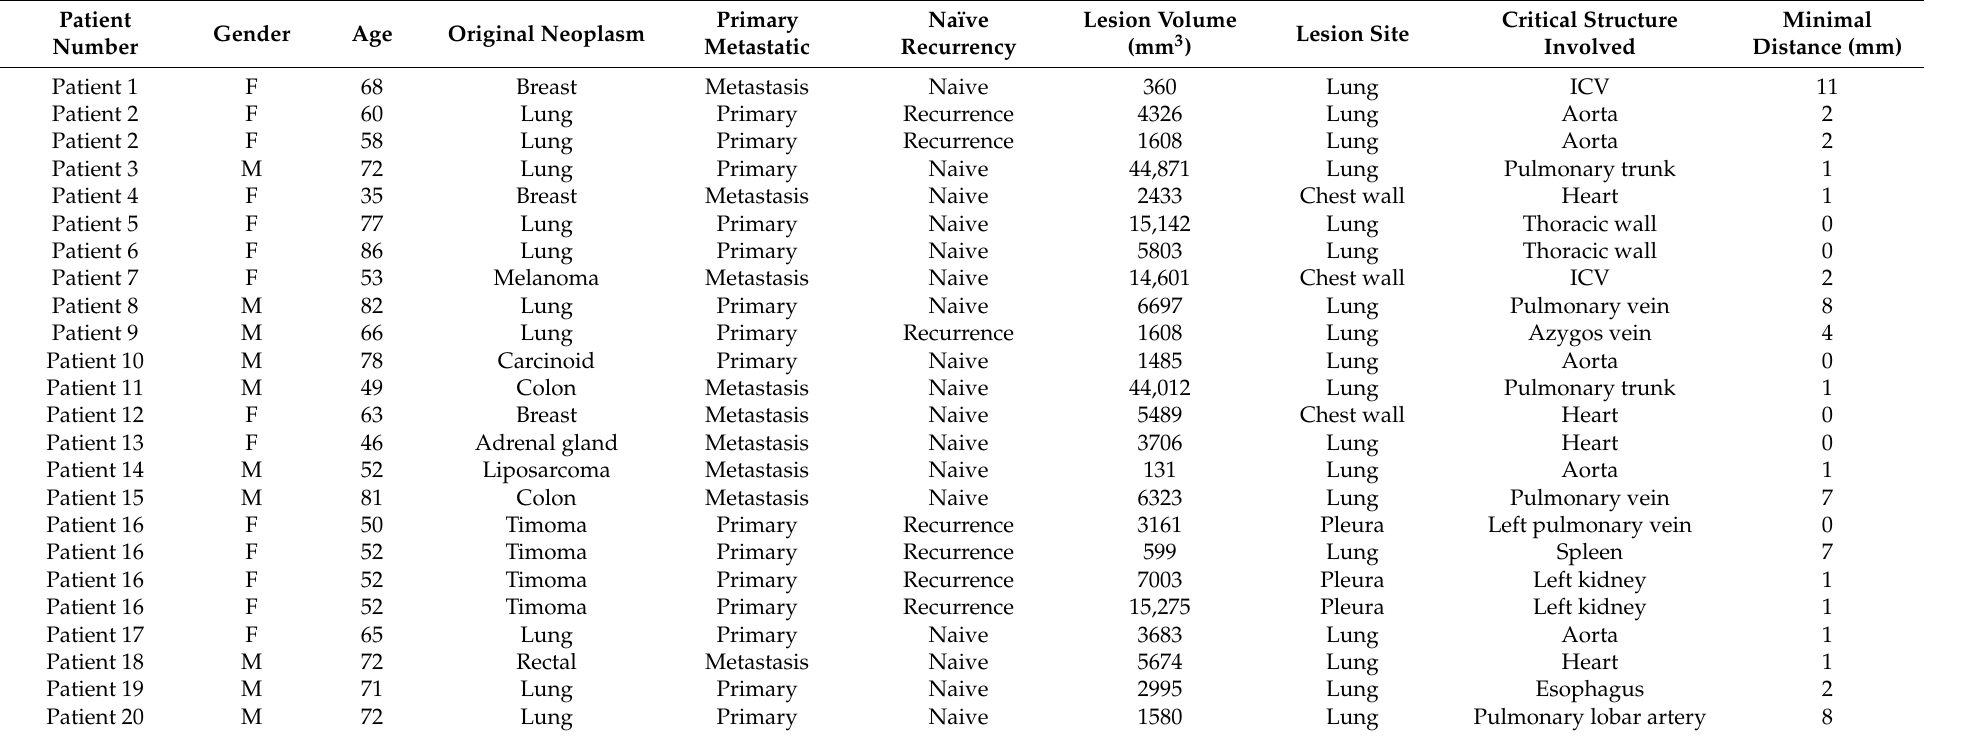
Table 1. Study population